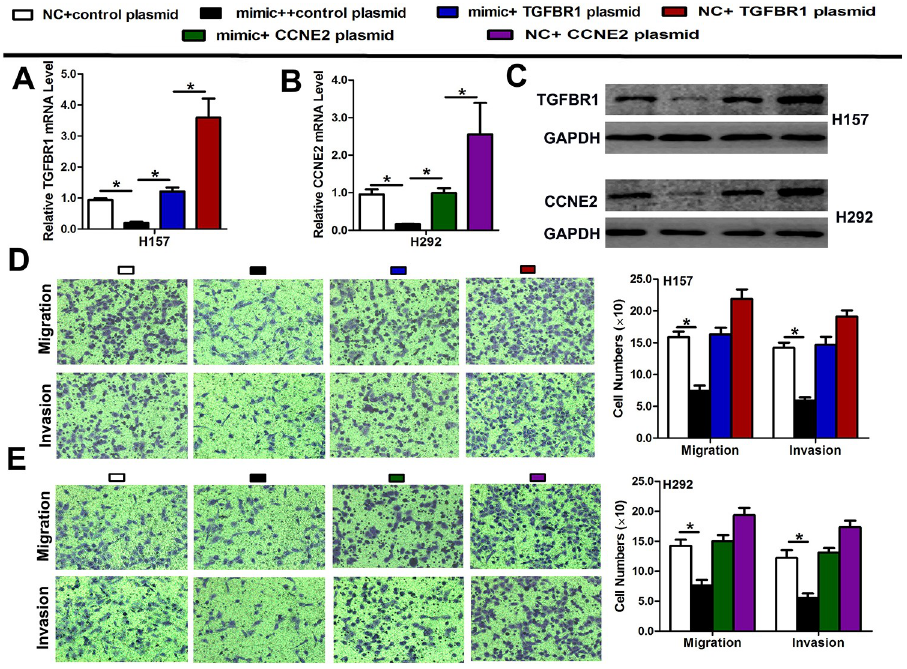
Fig 6. Rescue assays were performed to confirm that TGFBR1 and CCNE2 are the functional targets of miR-3607- 3p. (A-C) The mRNA and protein levels of TGFBR1 and CCNE2 in H157 and H292 cell lines with co-transfection of miR-3607-3p mimic and pEGFP-C1 plasmid containing TGFBR1 and CCNE2 CDS sequence. (D-E) Transwell assay of co-transfection cell with miR-3607-3p mimic and TGFBR1 and CCNE2 plasmid. Data are presented as means ± standard deviation from triplicate experiments. � , P <